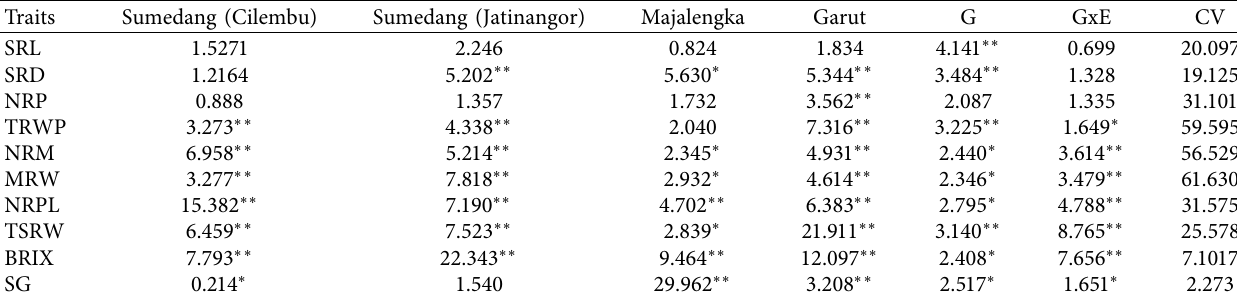
Table 3: Analysis of variance of ten agronomic traits observed.